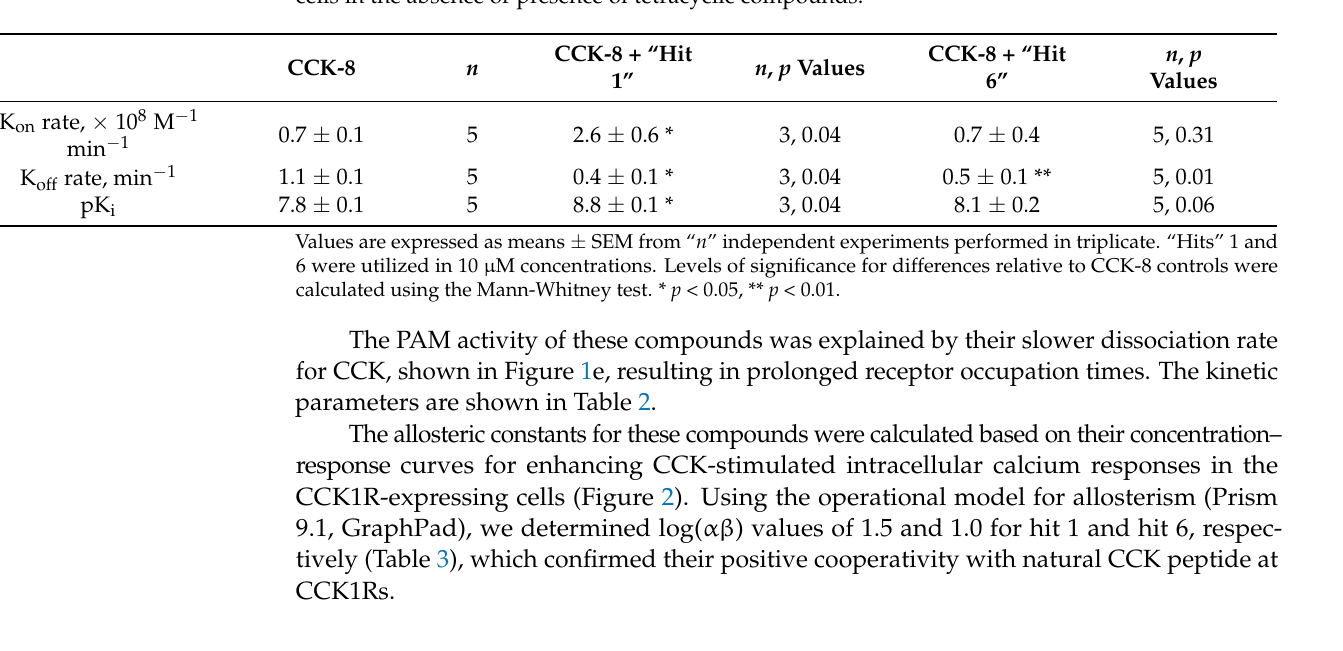
Figure 1. Pharmacologic profiles of “hits” 1 and 6. Shown are the structures of these two ligands, as well as evidence for their positive allosteric modulation of CCK action to stimulate intracellular calcium using Fura-8-AM at the CCK1R expressed on the CHO-CCK1R cell line ( a ), with no effect on CCK2R in the analogous CHO-CCK2R cell line ( b ) and no significant endogenous agonist activity at CCK1R in the CHO-CCK1R cell line ( c ) or at parental CHO cells ( d ). “Hits” 1 and 6 were utilized in 10 µ M concentrations. Maximal intracellular calcium responses were determined using 0.1 mM ATP targeting an endogenous CHO cell receptor. Values represent means ± SEM of data from a minimum of 5 independent experiments performed in duplicate and are analyzed in Table 1. Both ligands exerted their positive allosteric modulatory effect on CCK action at CCK1R by prolonging the peptide off rate ( e ). Kinetic data represent 5 independent experiments, with results analyzed in Table 2. Table 2. Kinetic parameters for CCK binding to CCK1R-expressing membranes from CHO-CCK1R cells in the absence or presence of tetracyclic